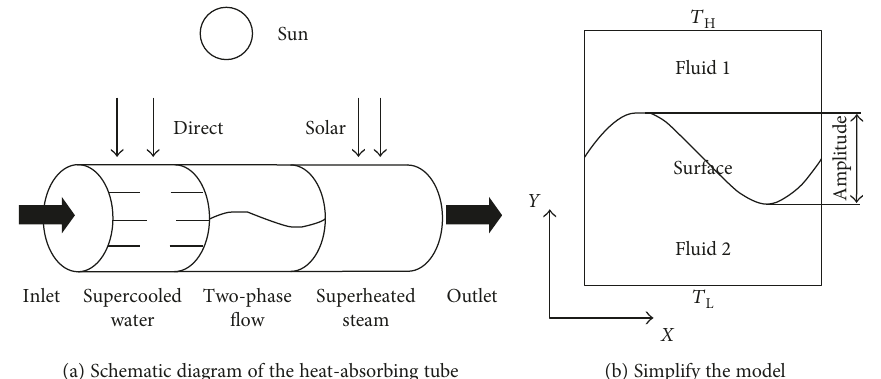
Figure 1: Physical model.